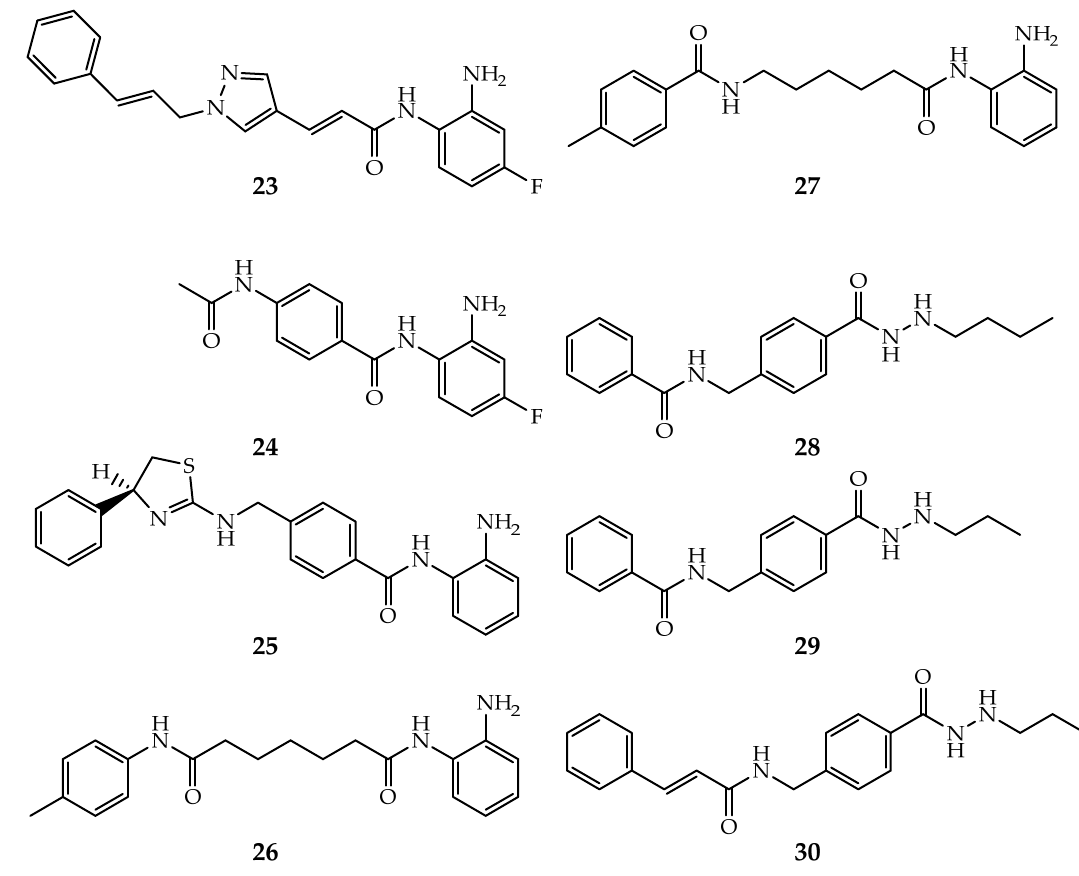
Figure 8. Selective inhibitors of HDAC3.